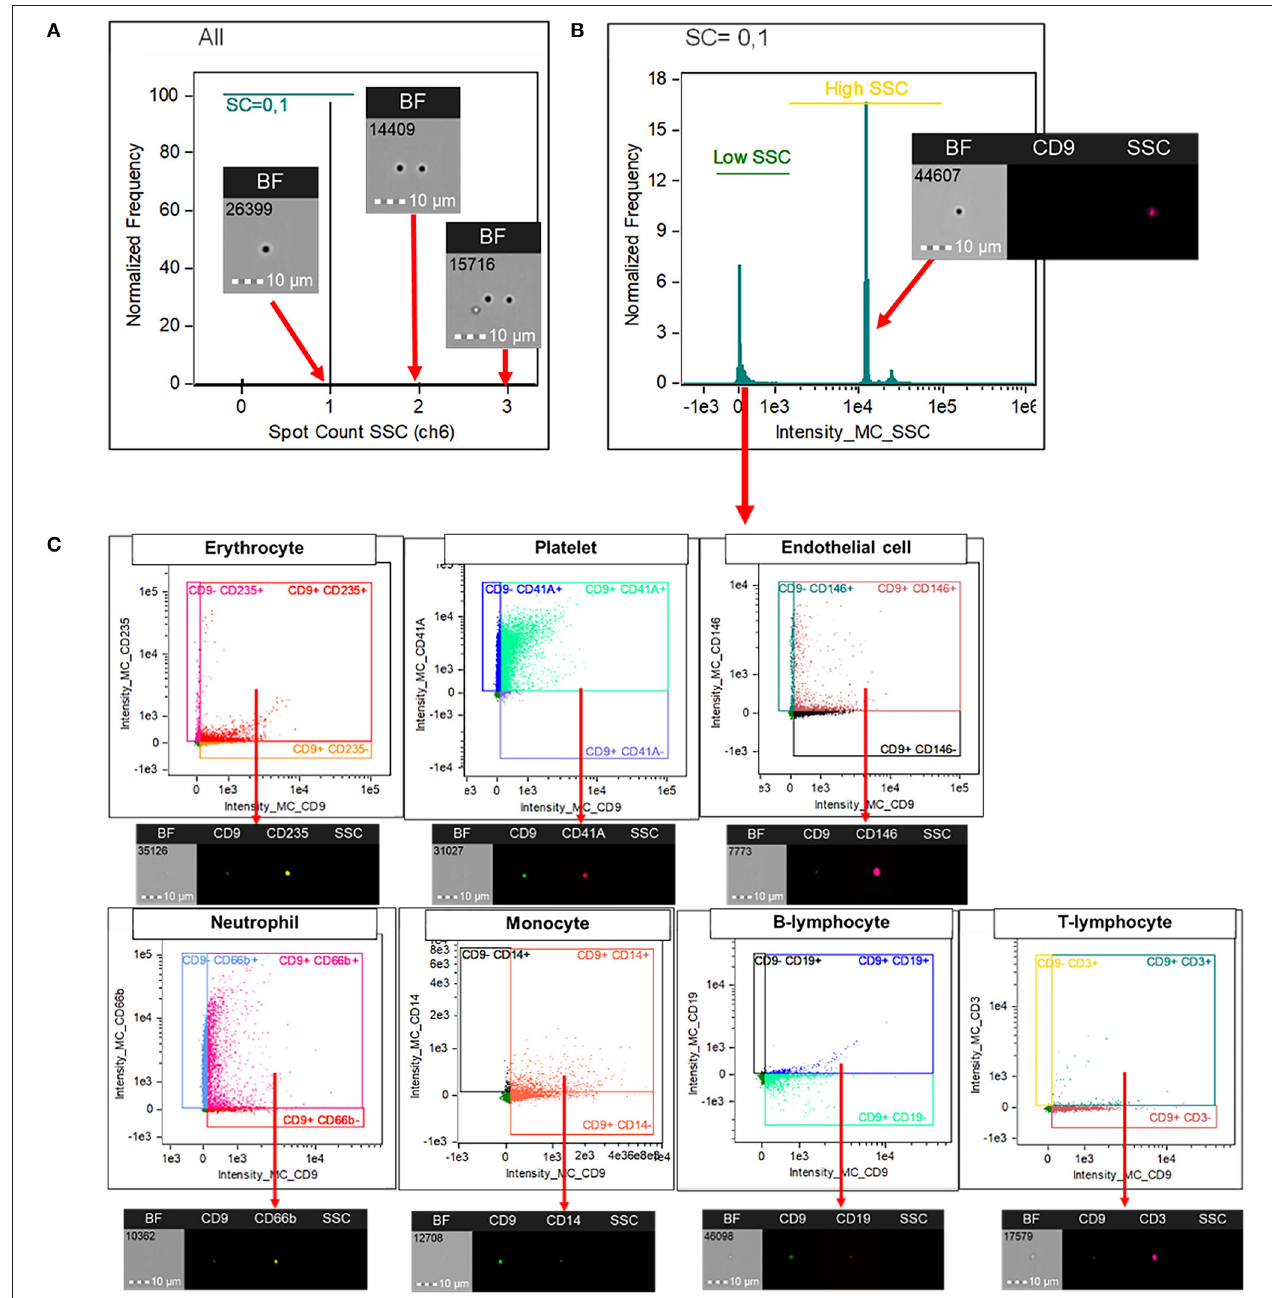
FIGURE 1 | Imaging flow cytometry analysis for the identification of EVs’ subtypes. Image Data Exploration and Analysis Software (IDEAS ® ) version 6.2 was used for the analysis. Doublets were excluded using “Spot count” on SSC channel (A) . This function is an image-based propriety software function that is suitable for counting events that appear as spots (e.g., parasite, phagocytosed particles) rather than a ring of fluorescent cell membrane. Events with spot counts of more than one was categorized as doublets and excluded from the analysis. Among singlets, large EVs were gated based on their intrinsically low SSC intensity (B) . Extracellular vesicles, subtyped by their cellular origin, were identified with a double positivity of CD9 and their corresponding markers; CD235 for erythrocytes, CD41A for platelets, CD146 for endothelial cells, CD66b for neutrophils, CD14 for monocytes, CD19 for B lymphocytes, and CD3 for T lymphocytes (C) . CD, cluster of differentiation; SSC, side scatter; EV, extracellular